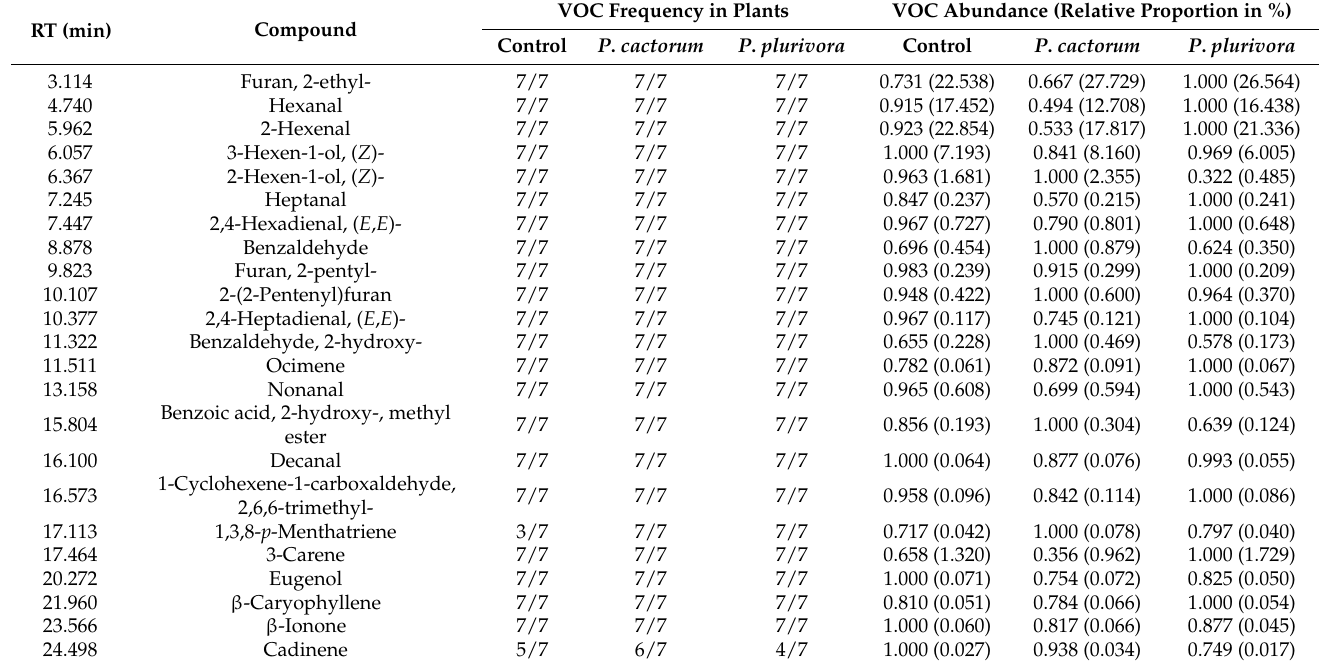
Table 2. Leaf volatile organic compounds (VOCs) identified in hybrid poplar at day 9 post-inoculation. VOC abundance values are expressed as a ratio to the maximum value for the particular compound across each row. RT, retention time.